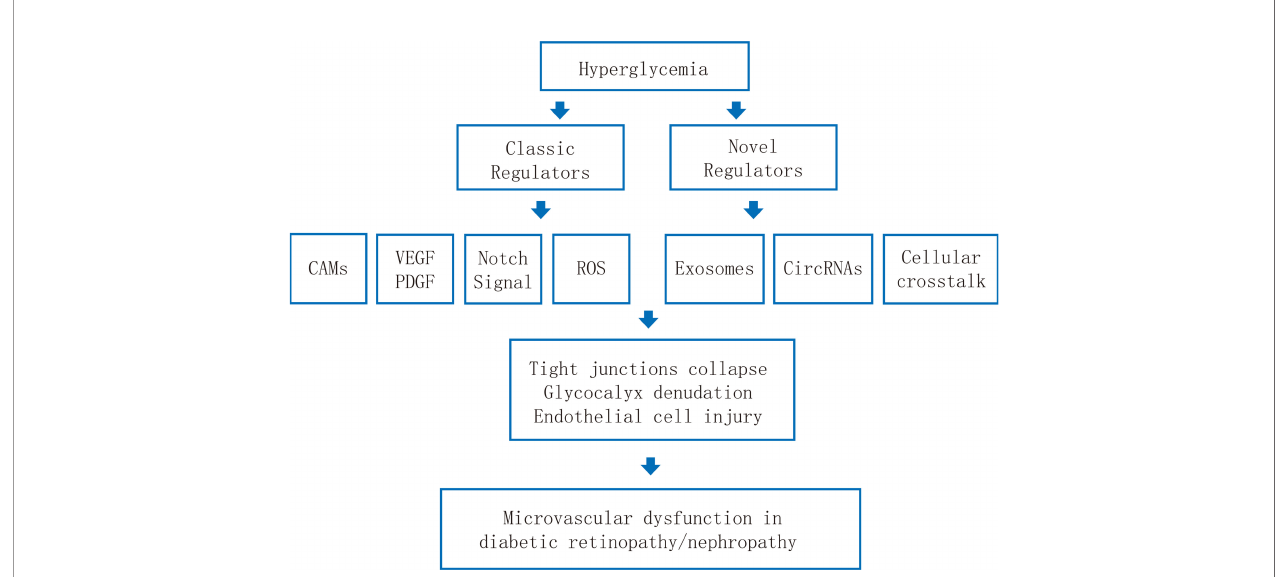
FIGURE 1 | Schematic illustration of the pathological mechanisms of endothelial dysfunction in diabetic retinopathy and diabetic